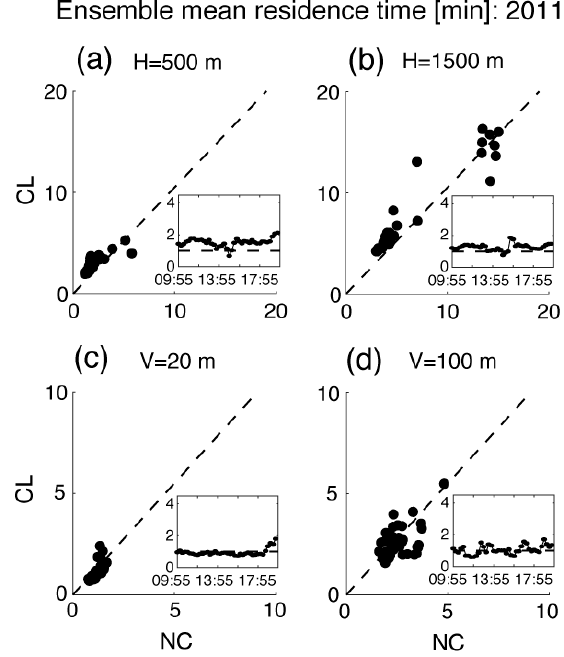
Figure 7. Scatter plots of ensemble mean residence time within horizontal radii of ( a ) 500 m and ( b ) 1500 m from each particles release point and vertical depths of ( c ) 20 m and ( d ) 100 m above each particles’ release level. The no-canopy simulation (2011NC) is plotted on the x-axis and the control simulation (2011CL) is plotted on the y-axis. Time series of the ratio of mean residence times are included in inset panels (x-axis: time [EDT]; y-axis: 2011CL mean residence time divided by 2011NC mean residence time). The dashed line (at y = 1) shows where the 2011CL value equals the 2011NC